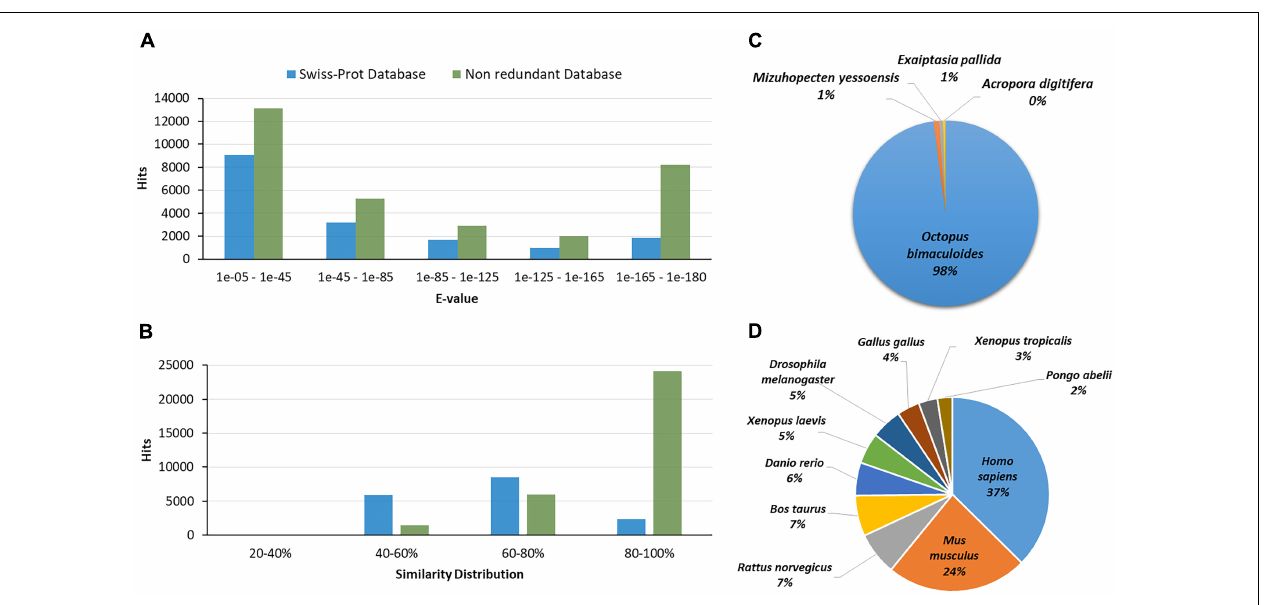
FIGURE 2 | (A) E-value distribution of the Blastx hits against the UniProt and Non-redundant (Nr) database for each transcript. (B) Similarity distribution of the Blastx hits against the UniProt and Nr database. (C) Species distribution of the top blast hits of the transcripts in the Nr database in the testis transcriptomic analysis of O. maya males. (D) Species distribution of the top blast hits of the transcripts in the UniProt database in the testis transcriptomic analysis of O. maya